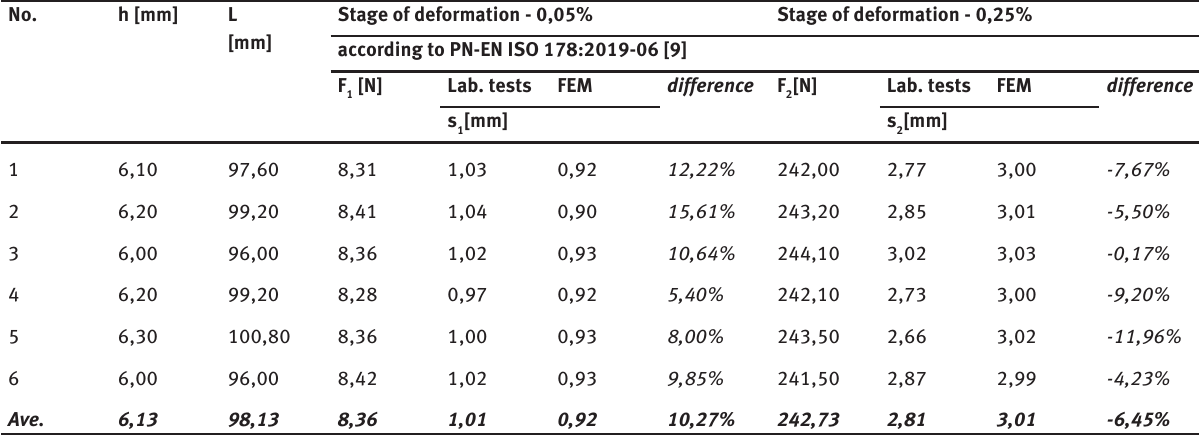
Table 7: Comparison of results of numerical analyses and laboratory tests for a model of a liner with a diameter of 350mm and 6,00mm wall